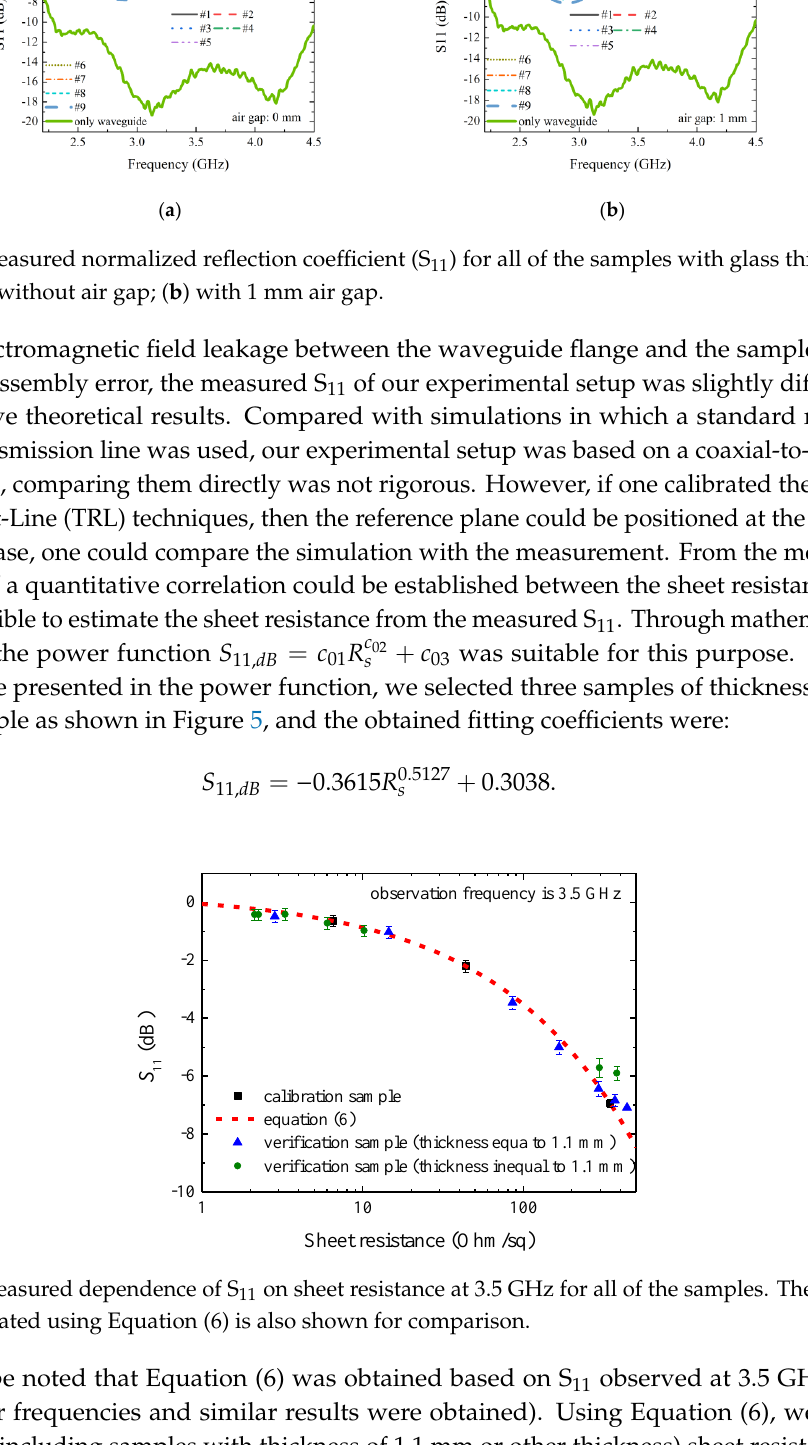
( b ) Figure 6. Measured effect of air gap: ( a ) S 11 vs. frequency; ( b ) standard deviation of S 11 . Using Equation (6), we analyzed the effect of measurement uncertainty of S 11 on the sheet resistance prediction accuracy as shown in Figure 7a. It can be seen that: 1. measurement accuracy increased with decreasing S 11 uncertainty; 2. measurement accuracy was better for higher resistance samples. These observations are helpful for understanding the measurement results of samples with sheet resistance below ~10 Ohm/sq. In Figure 7b, we present the measured effect of the horizontal place position of the sample on S 11 . We moved the sample along the x - and y -axes with 1 mm steps and 3 mm total displacement. With these nine measurements, we calculated the standard deviation. It can be seen that the change of S 11 was below 0.1 dB. Thus, the result indicates that the proposed method is, to some degree, insensitive to placement locations. This shall be helpful for real application.